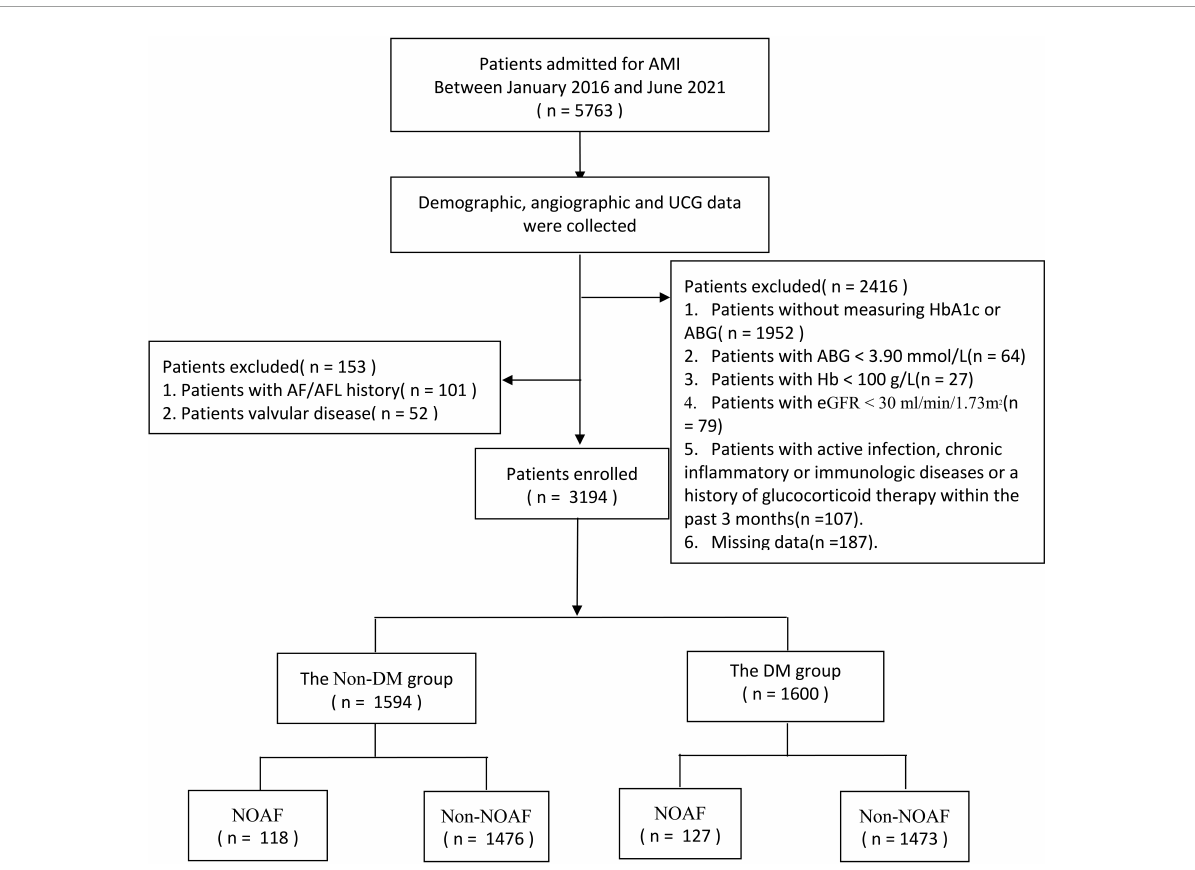
FIGURE1 Flow chart. AMI, acute myocardial infarction; UCG, ultrasound cardiogram; AF, atrial fibrillation; AFL, atrial flutter; HbA1c, hemoglobin A1c; ABG, admission fasting blood gulcose; eGFR, estimated glomerular filtration rate; DM, diabetes mellitus; NOAF, new-onset atrial fibrillation.